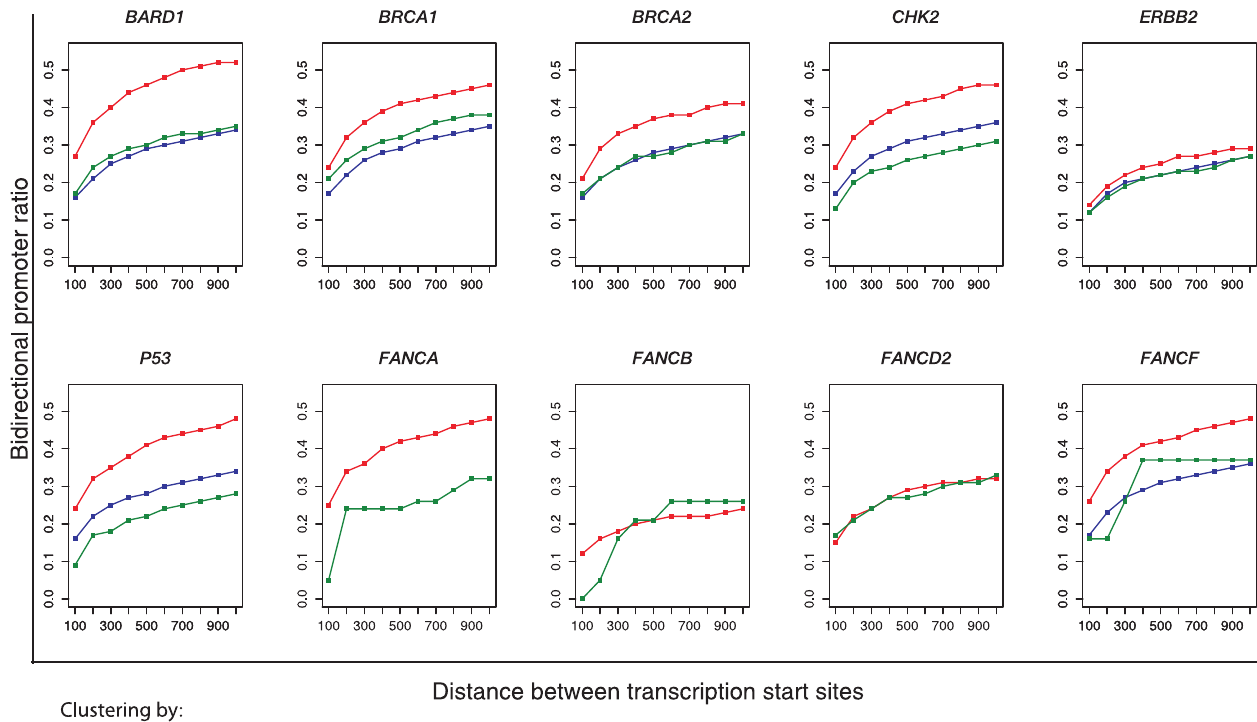
Figure 2. Clustering Analysis To Assess Bidirectional Promoters Clustering methods include microarray expression data (red), GO categories (blue), and psi -blastP alignments (green). The plots show the ratio of bidirectional promoters calculated for the cumulative number of genes found at each promoter distance. The named breast or ovarian cancer gene served as the reference gene for each type of cluster. The computational approach used to count the number of bidirectional promoters within each cluster is described in Methods. GO annotations (blue) were omitted when no data was